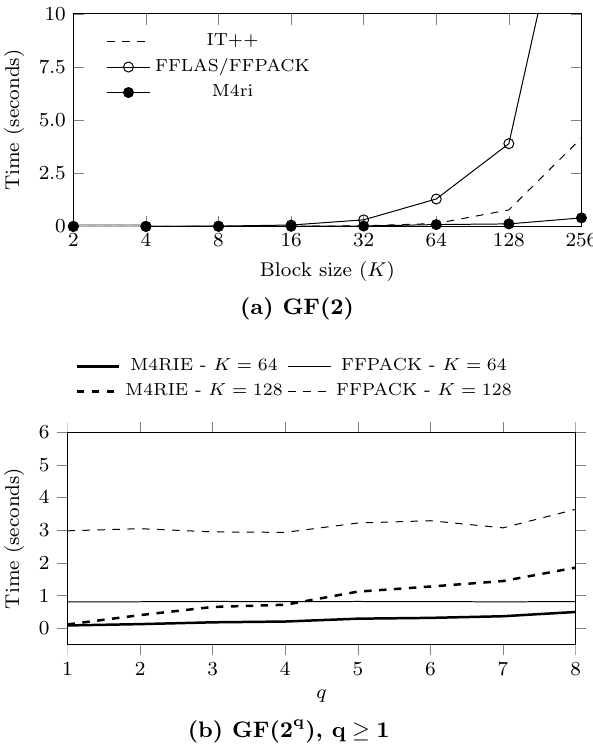
Figure 5: Required time for the inverse matrix cal-